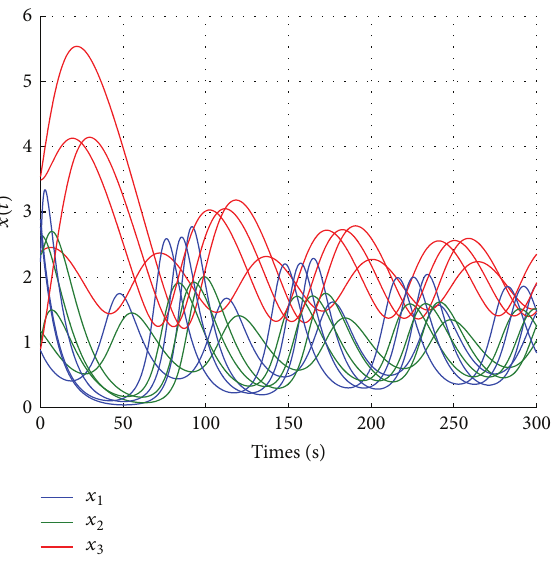
Figure 2: Time response of four oscillators.